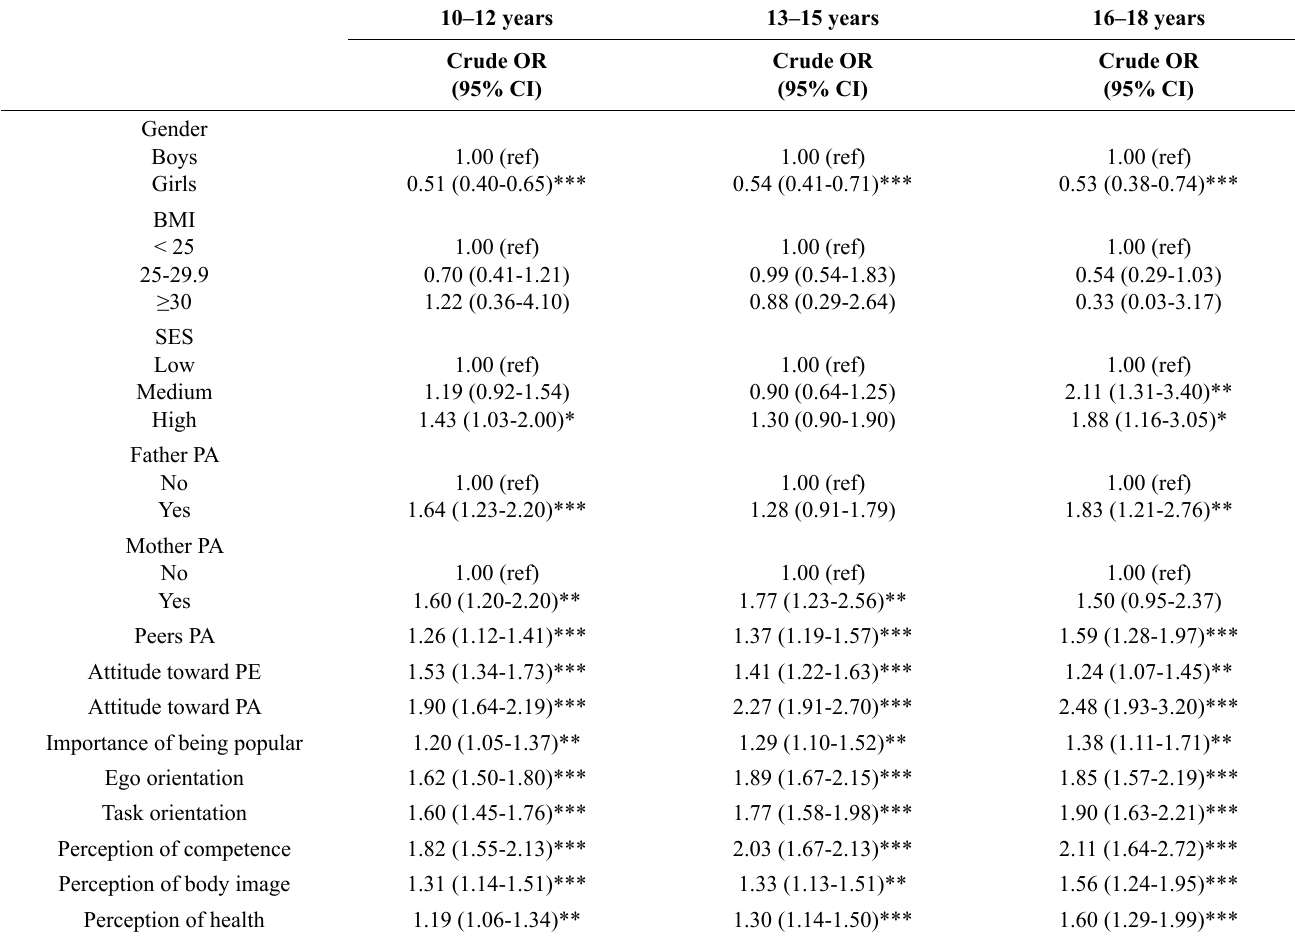
Table 2. Unadjusted logistic regression models examining correlates of PA by age